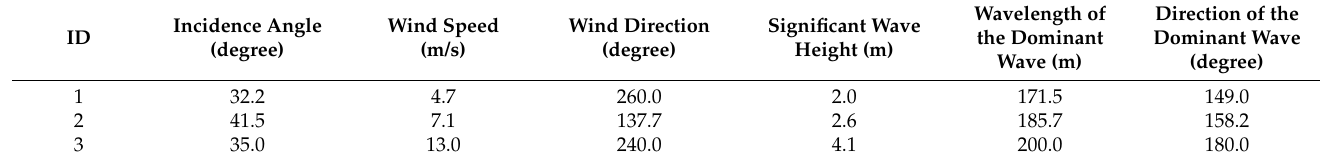
Table 1. The parameters of